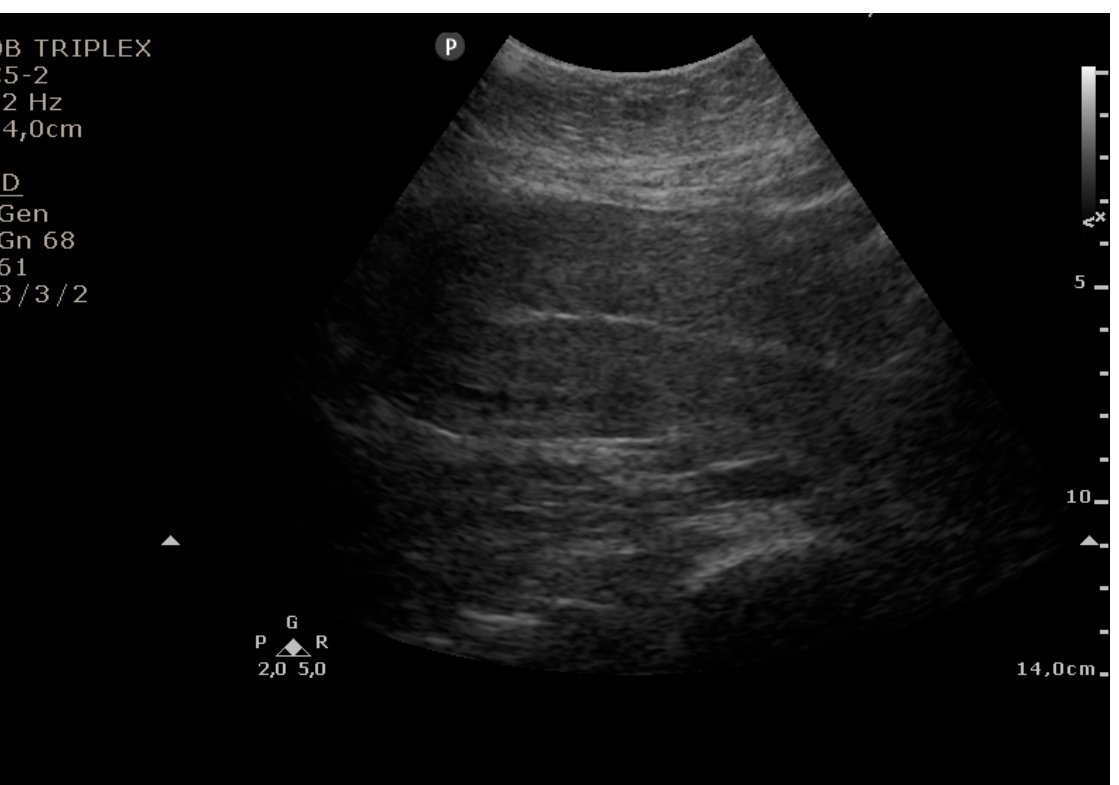
Figure 2. Grade 1: less than one-quarter of the endometrial length occupied by blood or debris.